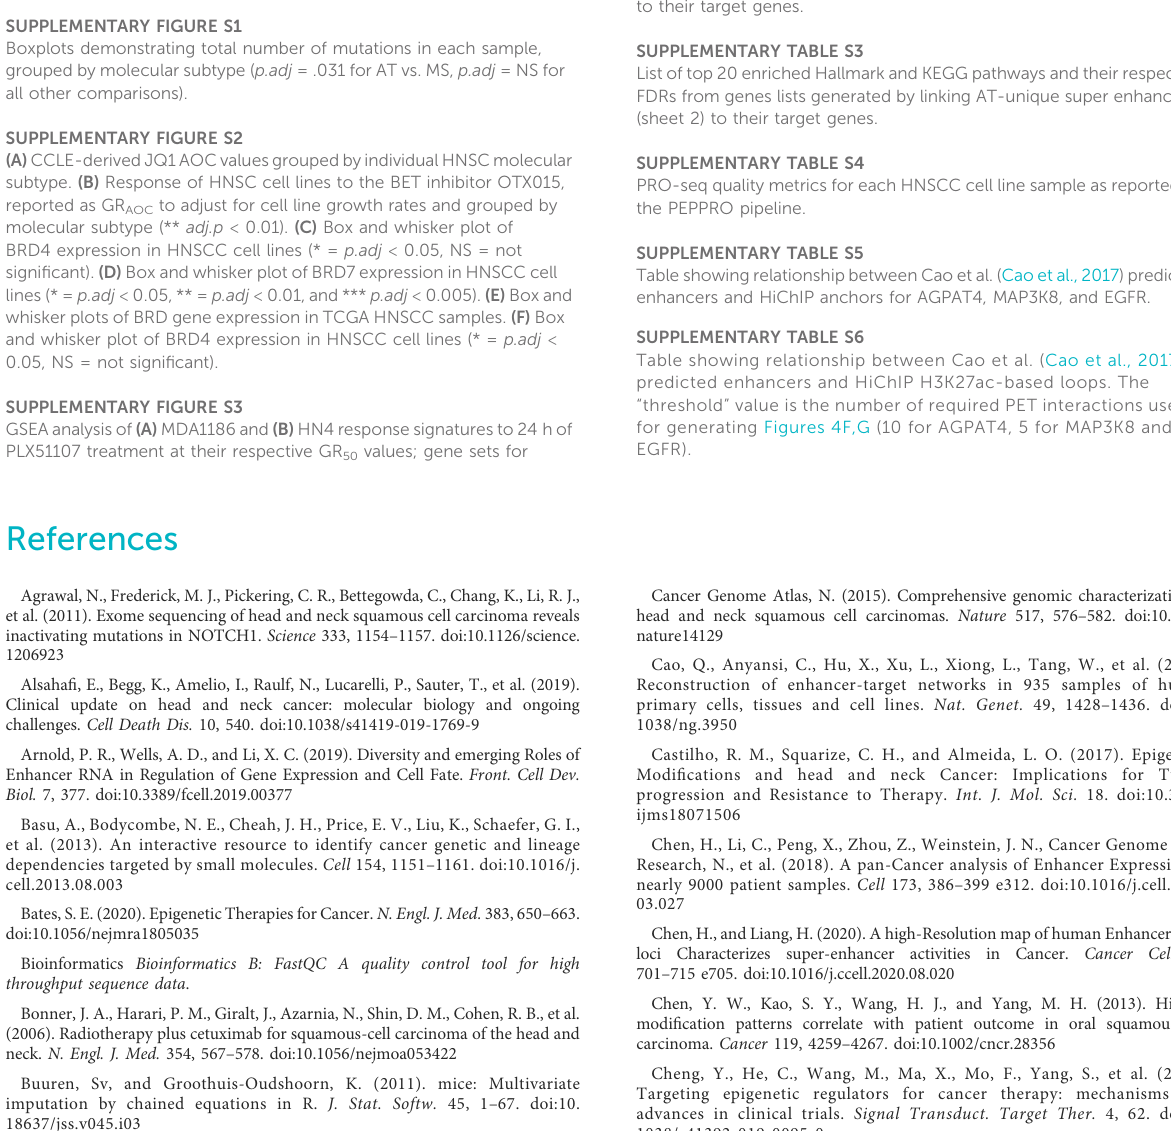
SUPPLEMENTARY TABLE S3 List of top 20 enriched Hallmark and KEGG pathways and their respective